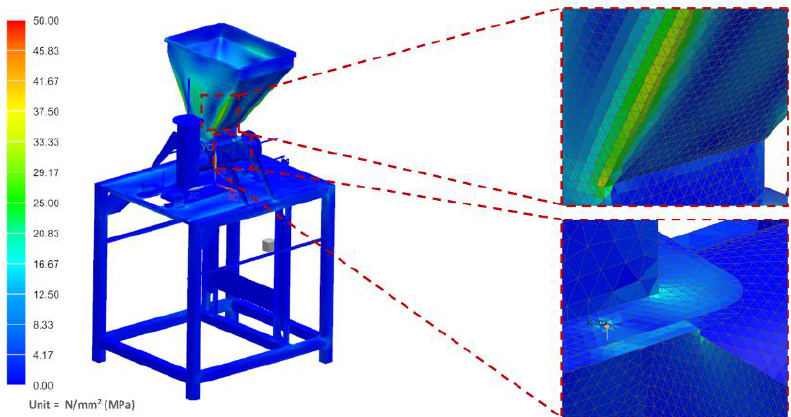
Figure 11. H–M–H stress map of the molding module.